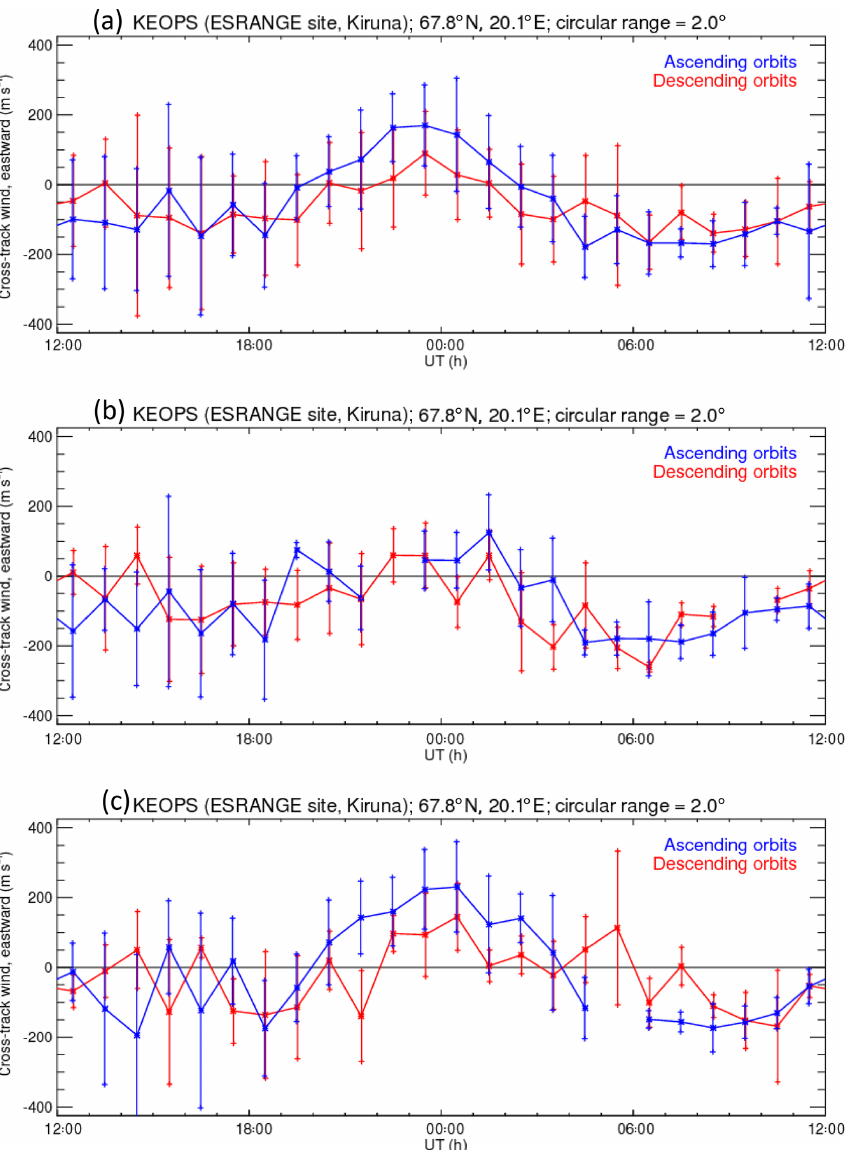
Figure 2. CHAMP observations over KEOPS during solar maximum 2001–2003. Panel (a) shows the average values for all data – ascend- ing (blue) and descending (red), panel (b) shows summer (May–August) averages and panel (c) shows winter (end October–early March)